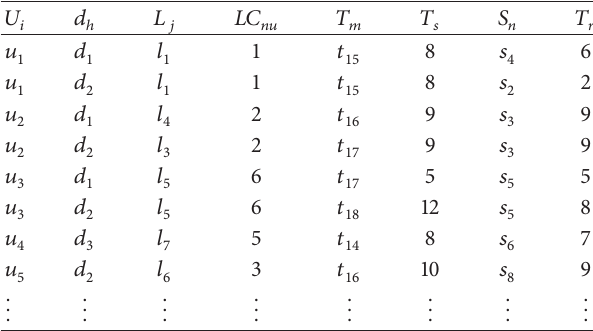
Figure 5: Two thresholds and three degrees. Table 3: Tourist